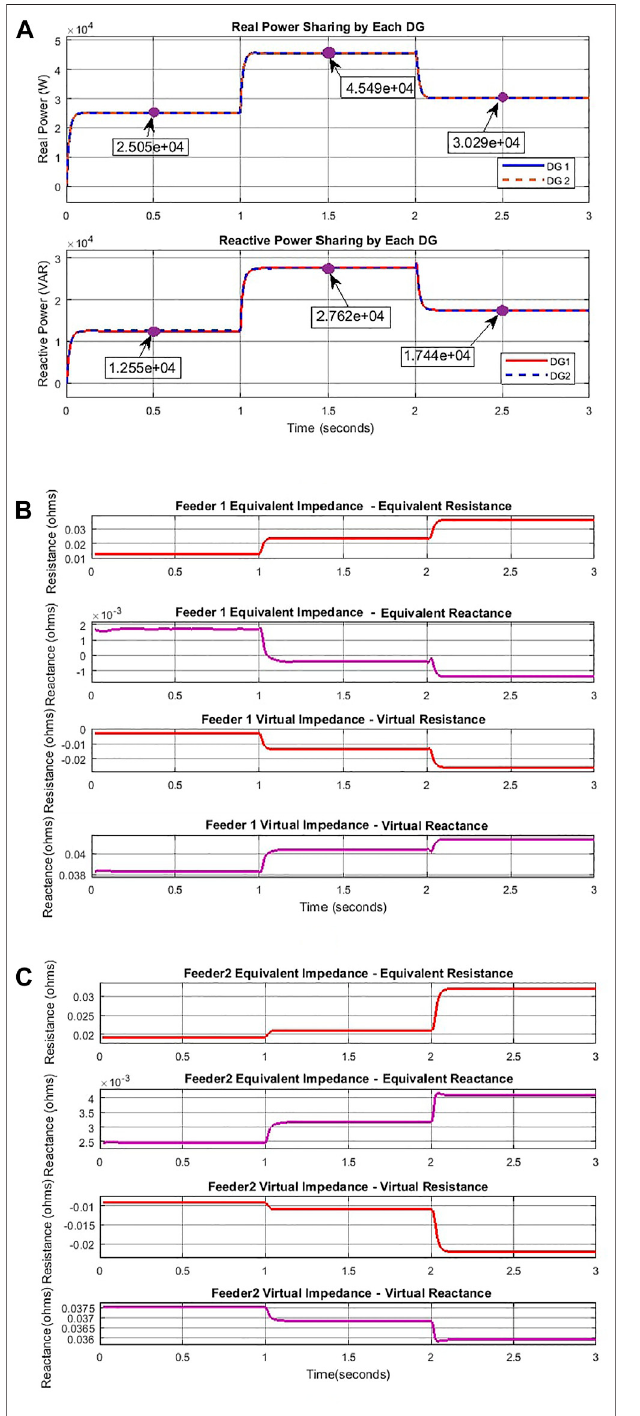
FIGURE 5 | Simulation results for UNEQUAL DG RATING: (A) power sharingbyDGs, (B) equivalentimpedanceandvirtualimpedanceofline1,and (C) equivalent impedance and virtual impedance of line